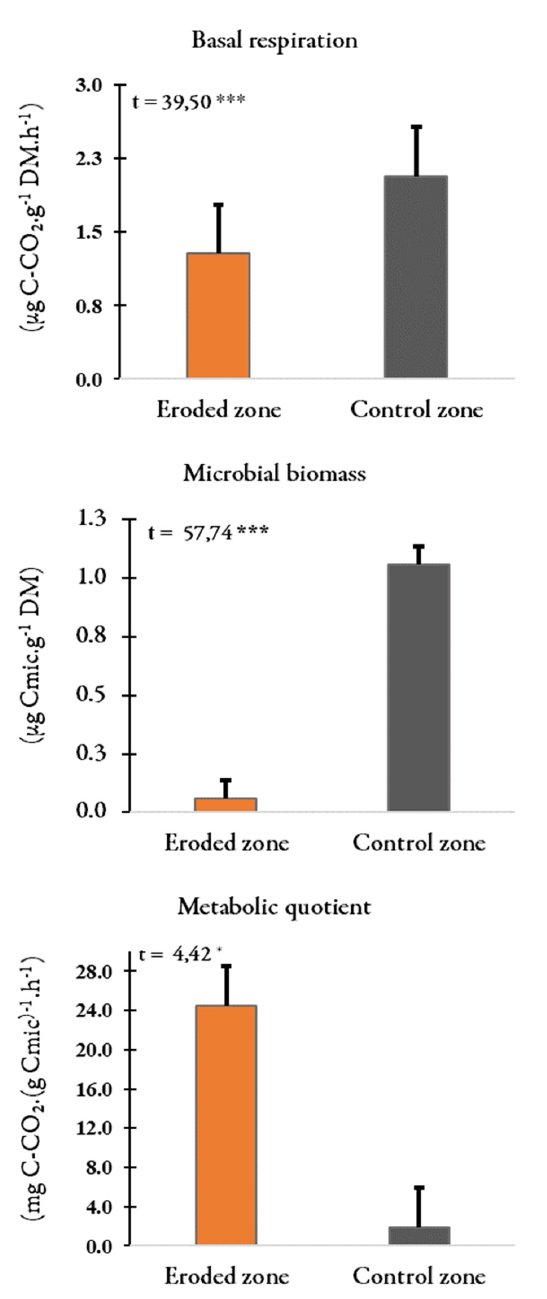
Figure 2. Variation in biological properties in eroded and control zones DM: Dry mass; Cmic: Carbon